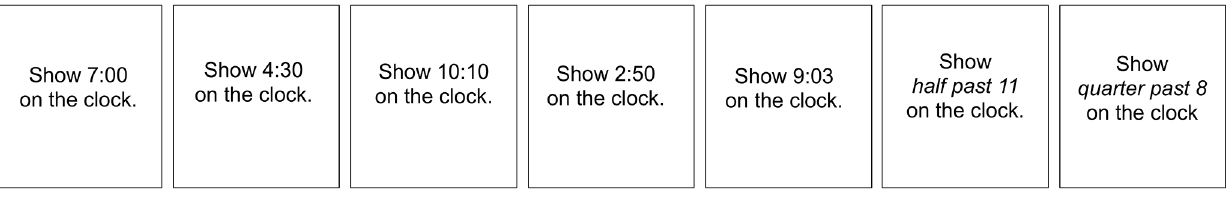
Figure 1. Playing cards for administering the Hand Positioning